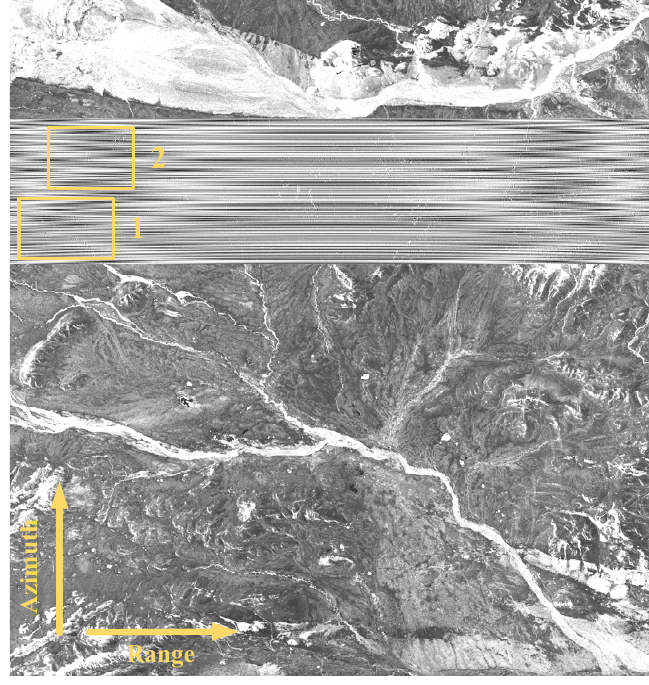
Figure 13. The SAR original image of Gaofen-3 (GF-3) with RFI.